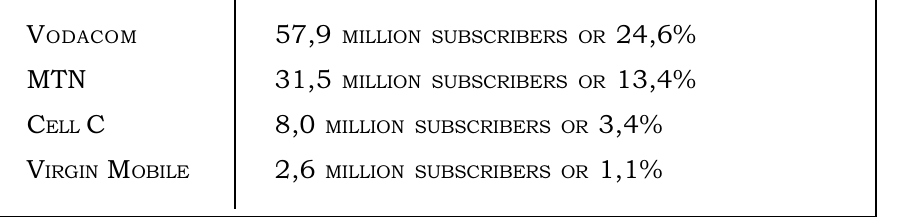
Table 4. Size of different operators